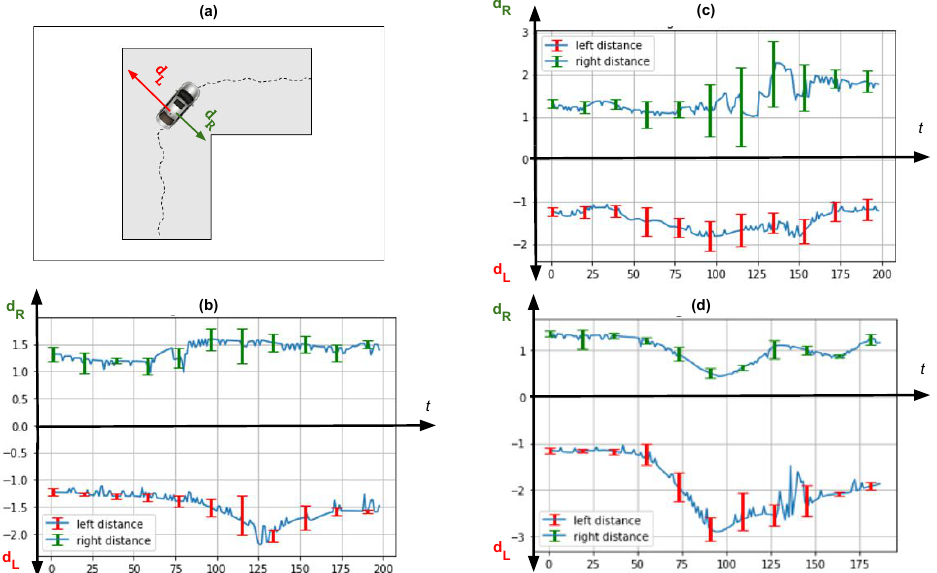
Figure 23. Right turn path performance test curves with error bars. Green error bars are related to the distance between the right wall and the center of the vehicle. Red error bars are related to the distance between the left wall and the center of the vehicle. ( a ) Left turn path. ( b ) Driving by a human operator. ( c ) Driving by the neural network trained with camera images. ( d ) Driving by the neural network trained with